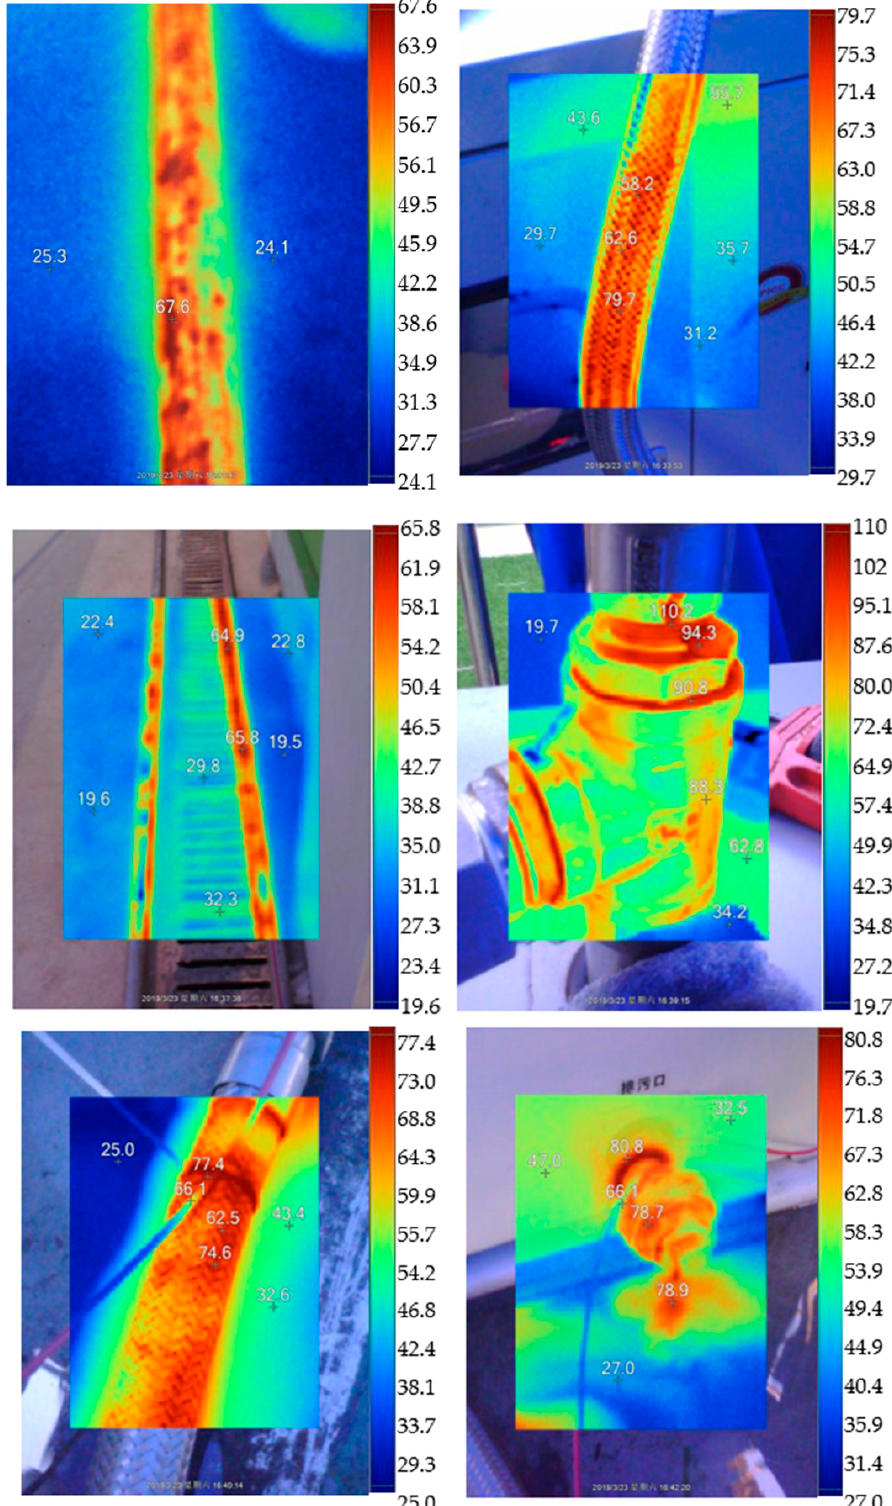
Figure 5. Temperature scanning of infrared thermal imager on the surface of the heating pipe and electromagnetic heating furnace.